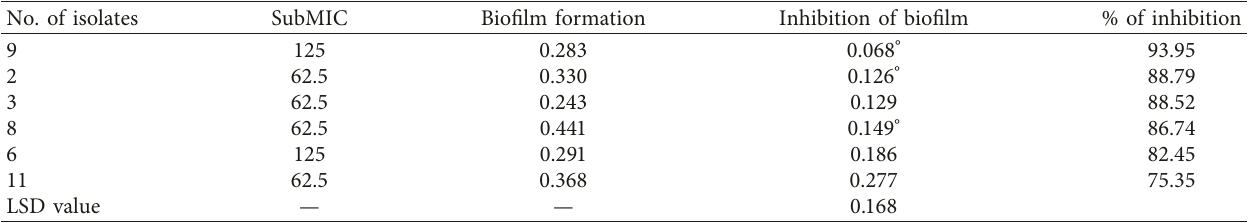
Table 11: The biofilm formation and biofilm inhibition activity of the hydantoin compound C6 in S. aureus isolates according to SubMIC. No. of isolates